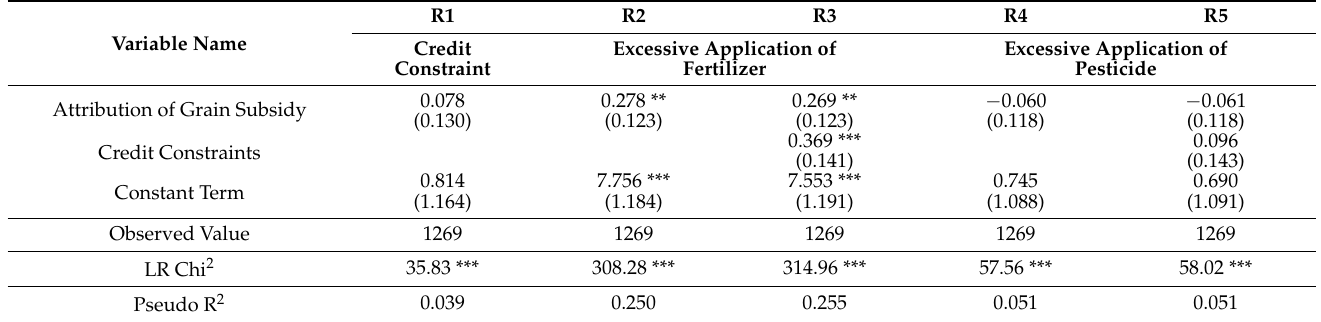
Table 7. Mediating Effect of Credit Constraints on the Impact of grain subsidy policy on farmers’ green production behavior.